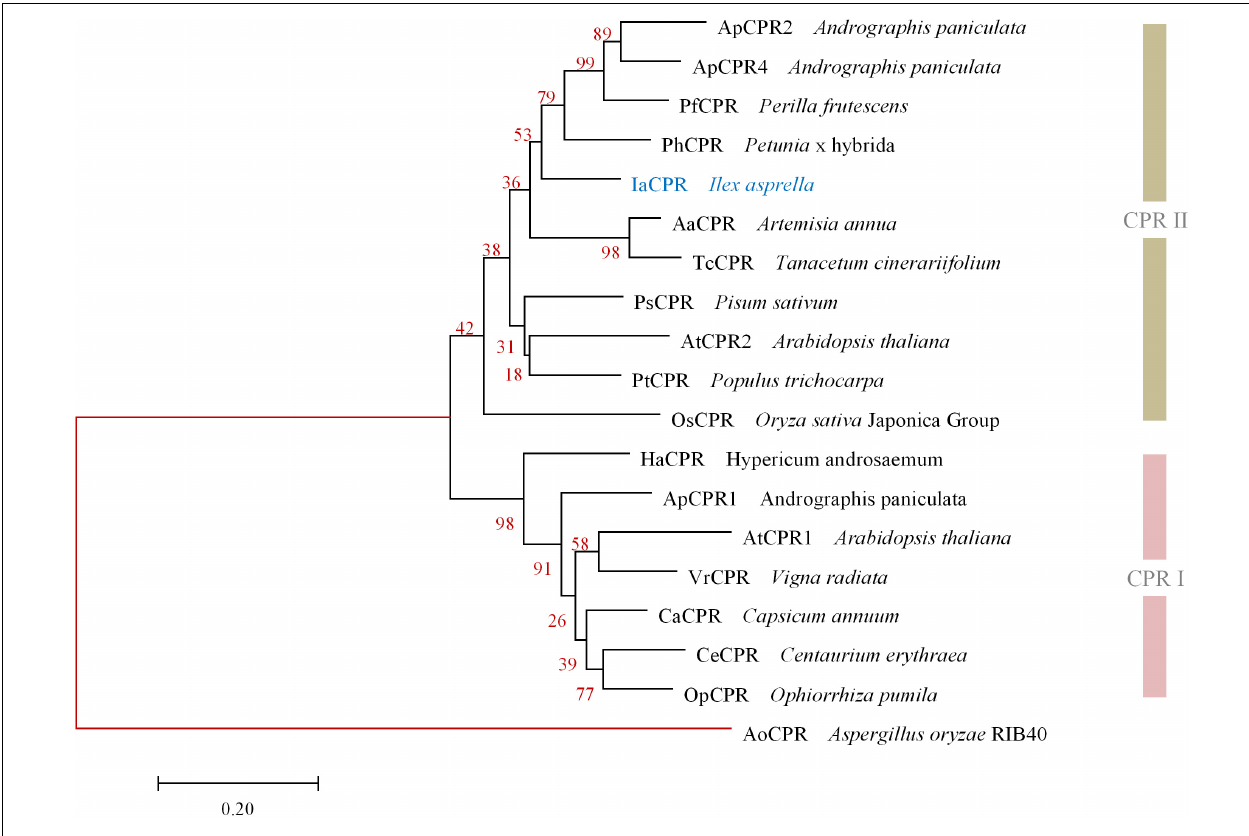
FIGURE 3 | Phylogenetic analysis of IaCPR with known CPRs. The gene names and sequences are given in Supplementary Material . Genes isolated in this study were colored in blue. Red branches represented outgroup.